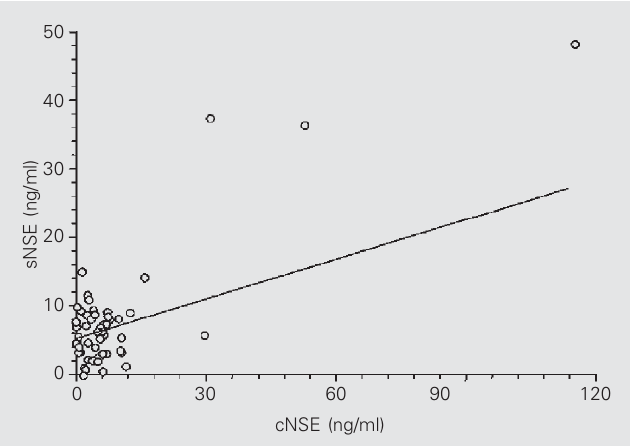
Figure 2. Nonparametric linear regression analysis of neuron-specific eno- lase levels in serum (sNSE) and neuron-specific enolase levels in cerebrospi- nal fluid (cNSE) for all subjects (N = 51). P = 0.16 (Kendall’s rank correlation coefficient tau b = 0.135808).